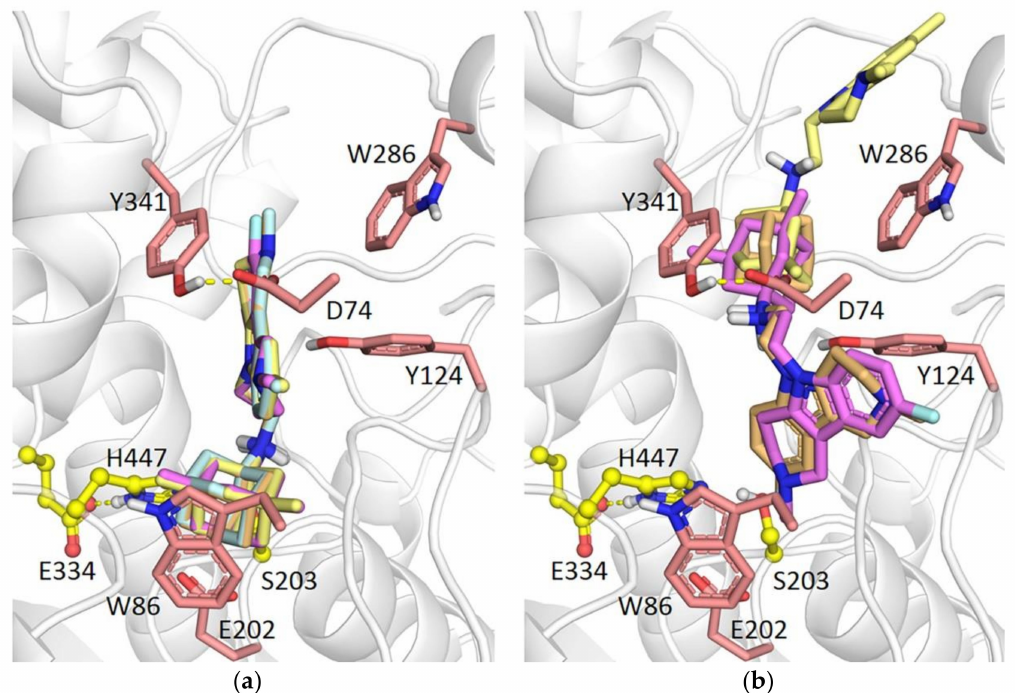
Figure 5. Docking of memantine and amantadine derivatives linked via the ethylene spacer to AChE (carbon atoms are shown in yellow for 4b , blue for 4e , purple for 4c and orange for 4f ). Panel ( a ): the best energy-scored pose based on molecular docking, which could be kinetically hindered. Panel ( b ): the binding pose ranked second in energy, with the amantadine/memantine group bound to the PAS. The γ -carboline group can bind to both the CAS and